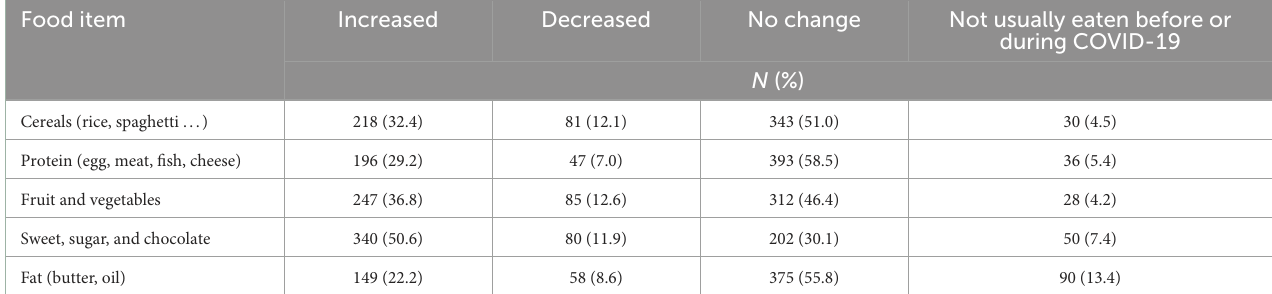
TABLE 5 The frequency of consumption of particular foods during the COVID-19 pandemic. Food item